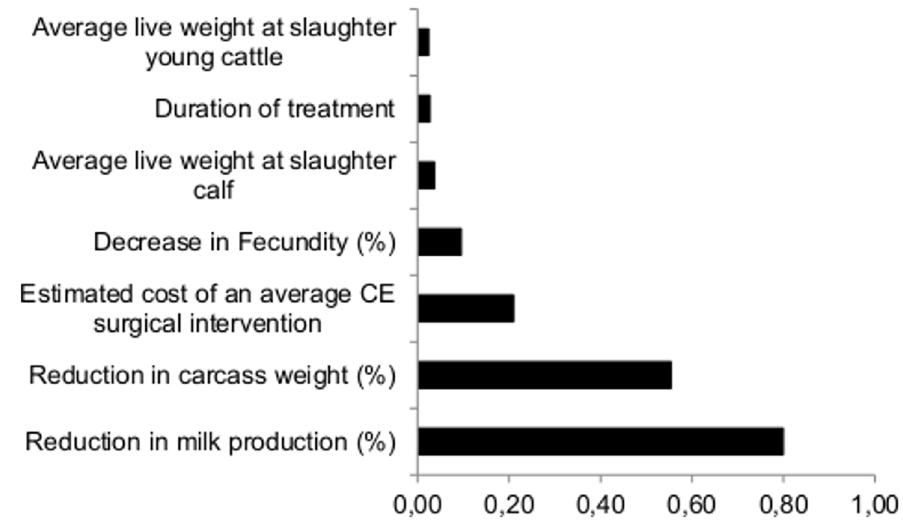
Figure 4. Estimated normalized regression coefficient showing the associations between uncertain parameters and total losses due to CE under scenario 1, A´ lava,